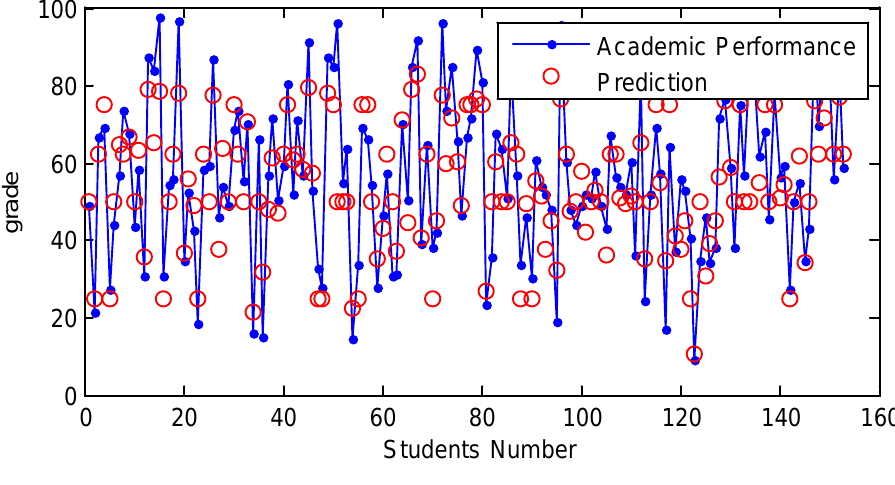
Graph 3. Comparison graph for educational